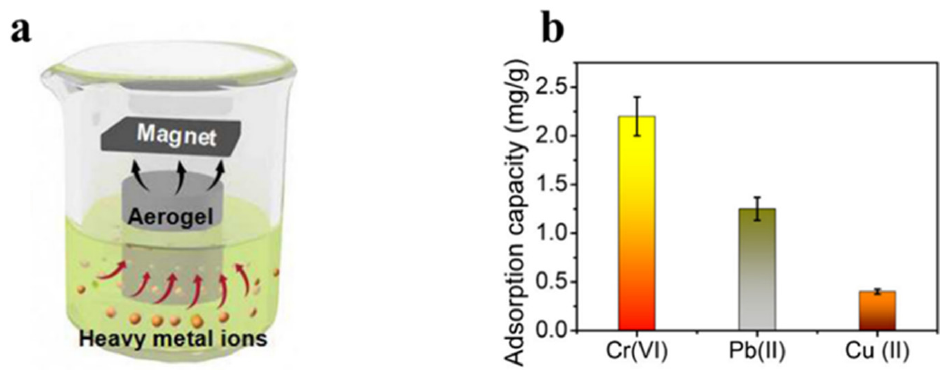
Figure 6. ( a ) Adsorption behavior of magnetic hybrid aerogels for heavy metal ions under magnetic conditions. ( b ) Maximum adsorption capabilities of magnetic hybrid aerogels for the absorption of Cr(VI), Pb(II), and Cu(II) ions.